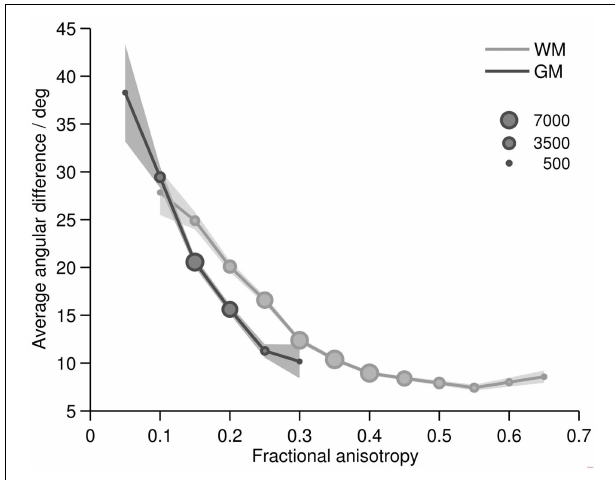
FIGURE 5 | Average difference between main MRI DT and Hist ST orientations in gray (dark line) and white (light line) matter as a function of FA. Marker size linearly represents the sizes of the voxel subsamples of the FA bins. FA bins with less than 100 voxels are not displayed. Confidence interval: 1.96 * standard error.